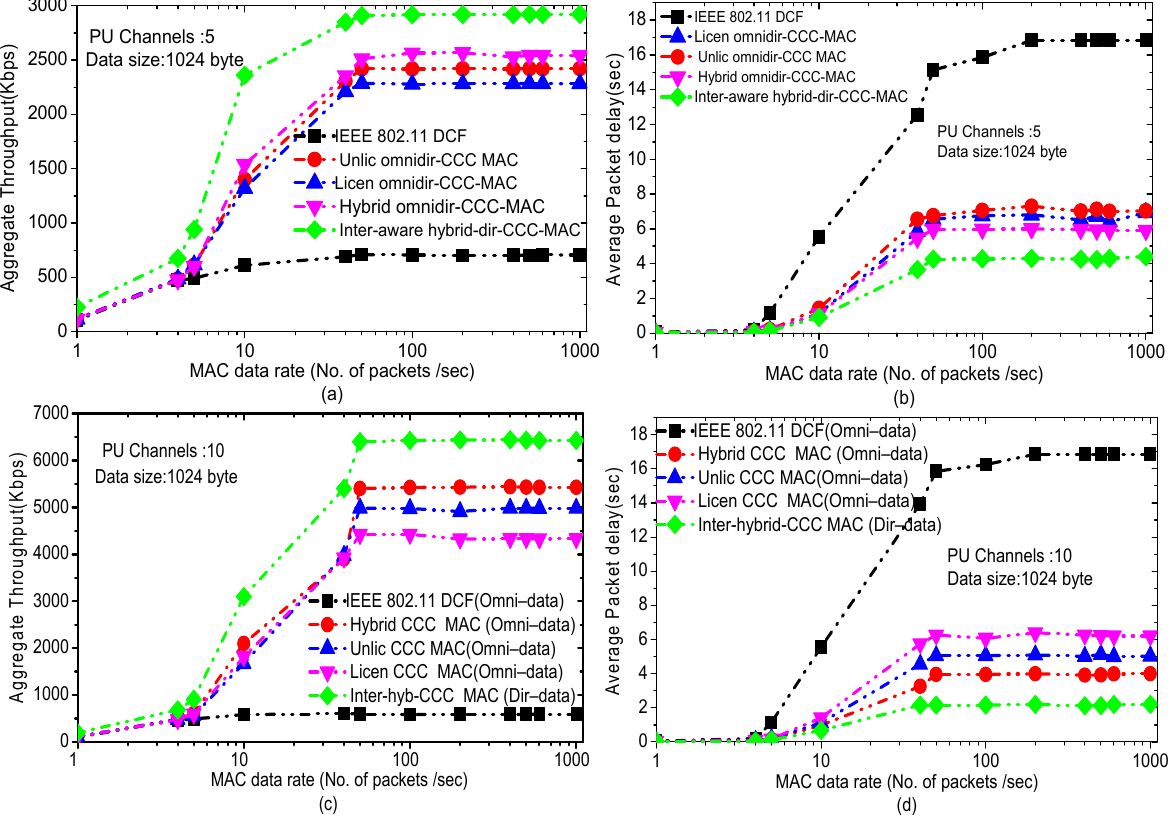
Figure 10. Aggregate throughput and average link delays calculation with data